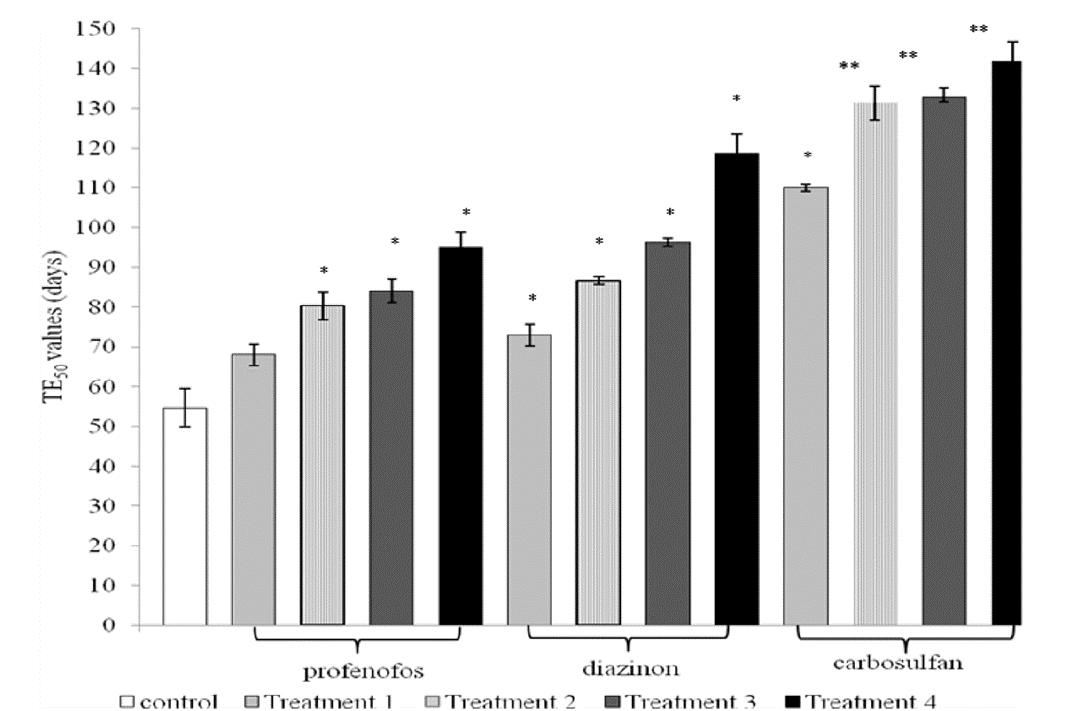
) of Polypedates cruciger exposed 50